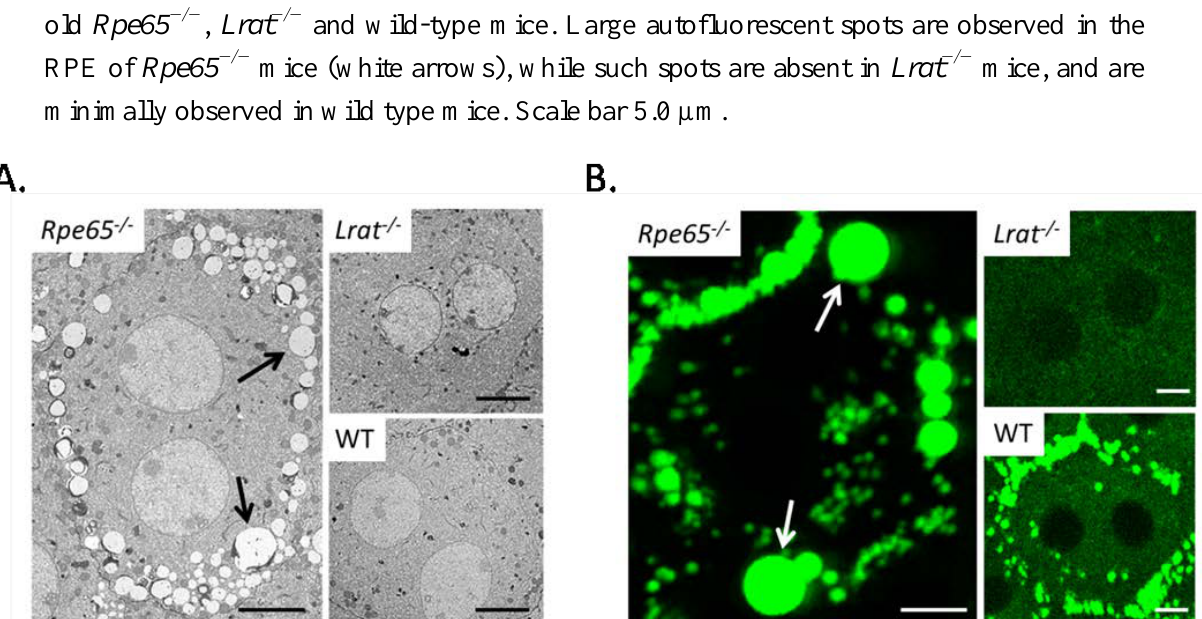
Figure 3. ( A ) Horizontal EM images of RPE in 3 month old Rpe65 −/− , Lrat −/−